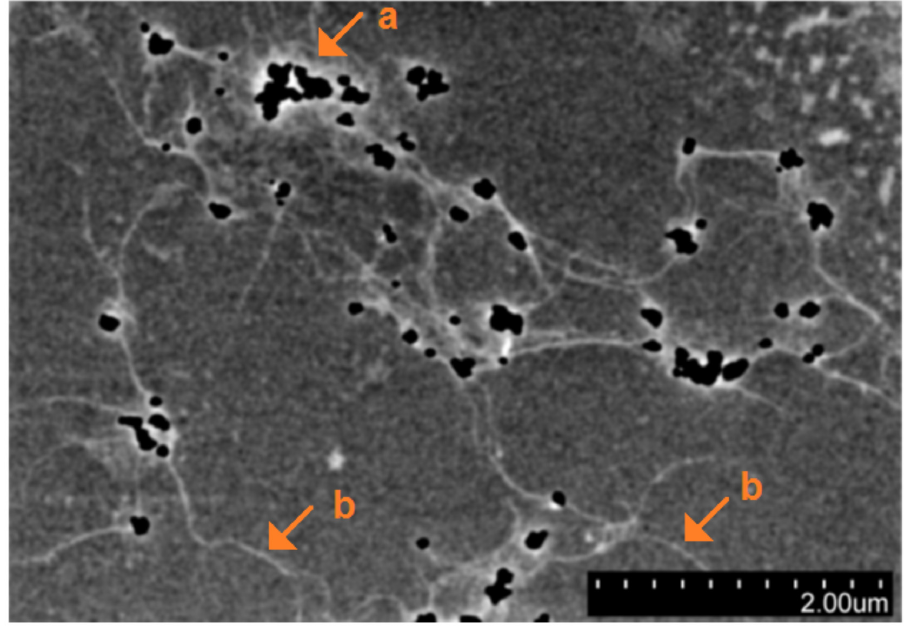
Figure 5. SEM images (overlay of contrast-enhanced images) of the aggregation of gold nanoparticles formed by the re- duction of HAuCl 4 (20 µM) with ascorbic acid (60 µM) in the presence of poly-DADMAC (100 ppm): ( a ) larger cluster of metal nanoparticles; ( b ) macromolecular filaments.